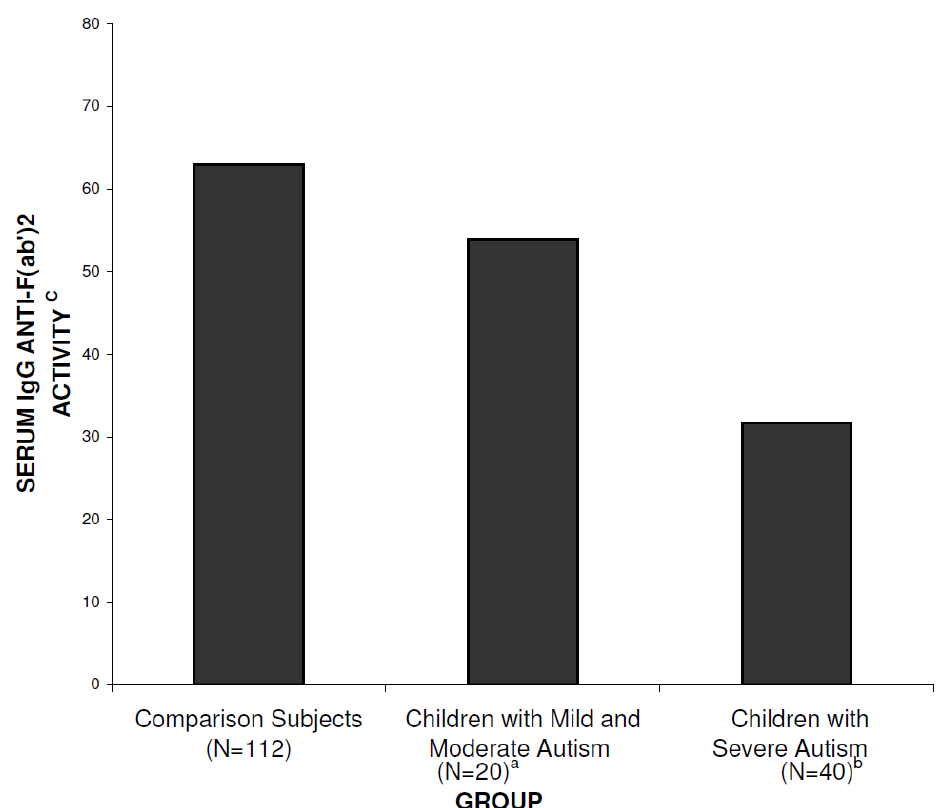
Figure 1. Mean serum IgG anti-F(ab’) 2 titers in the autism group and the typically control group. Notes: a Significant difference between the mild and moderate autism group and the comparison group (t = 3.14, df = 129, p = 0.002). b Significant difference between the severe autism group and the comparison group (t = 7.53, df = 96, p < 0.0001) and between the severe autism group and the mild and moderate autism group (t = 6.53, df = 48, p < 0.0001). c Results are expressed as the percentage of the absorbance of the test serum compared with a reference pool of 800 normal sera.